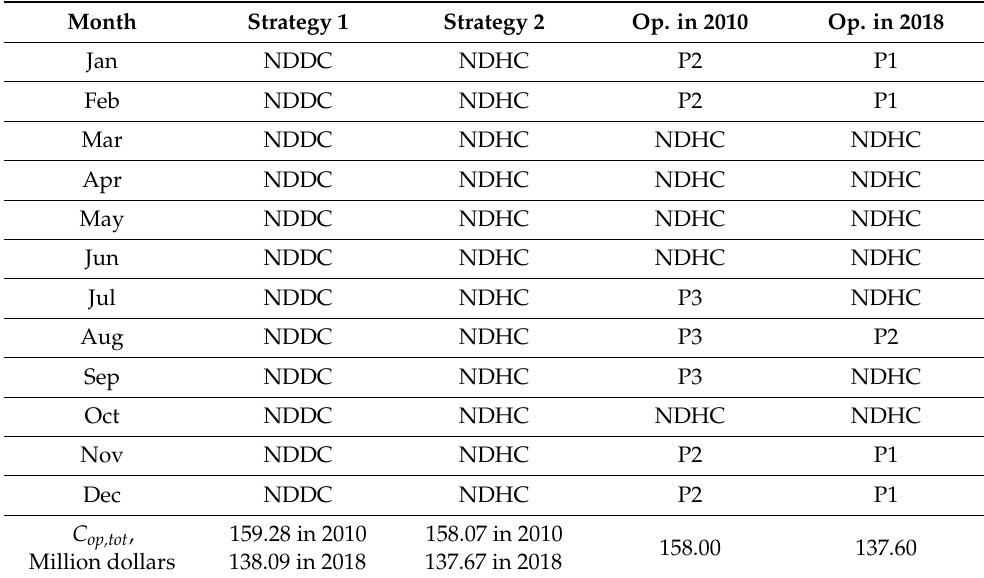
Table 9. Operation strategy corresponding to cost minimization of the hybrid cooling system.